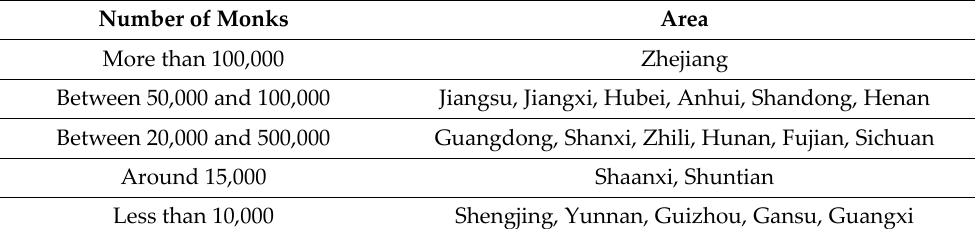
Table 5. The proportion of monks and Taoists in Jiangsu and Hunan provinces in the mid‑18th century.